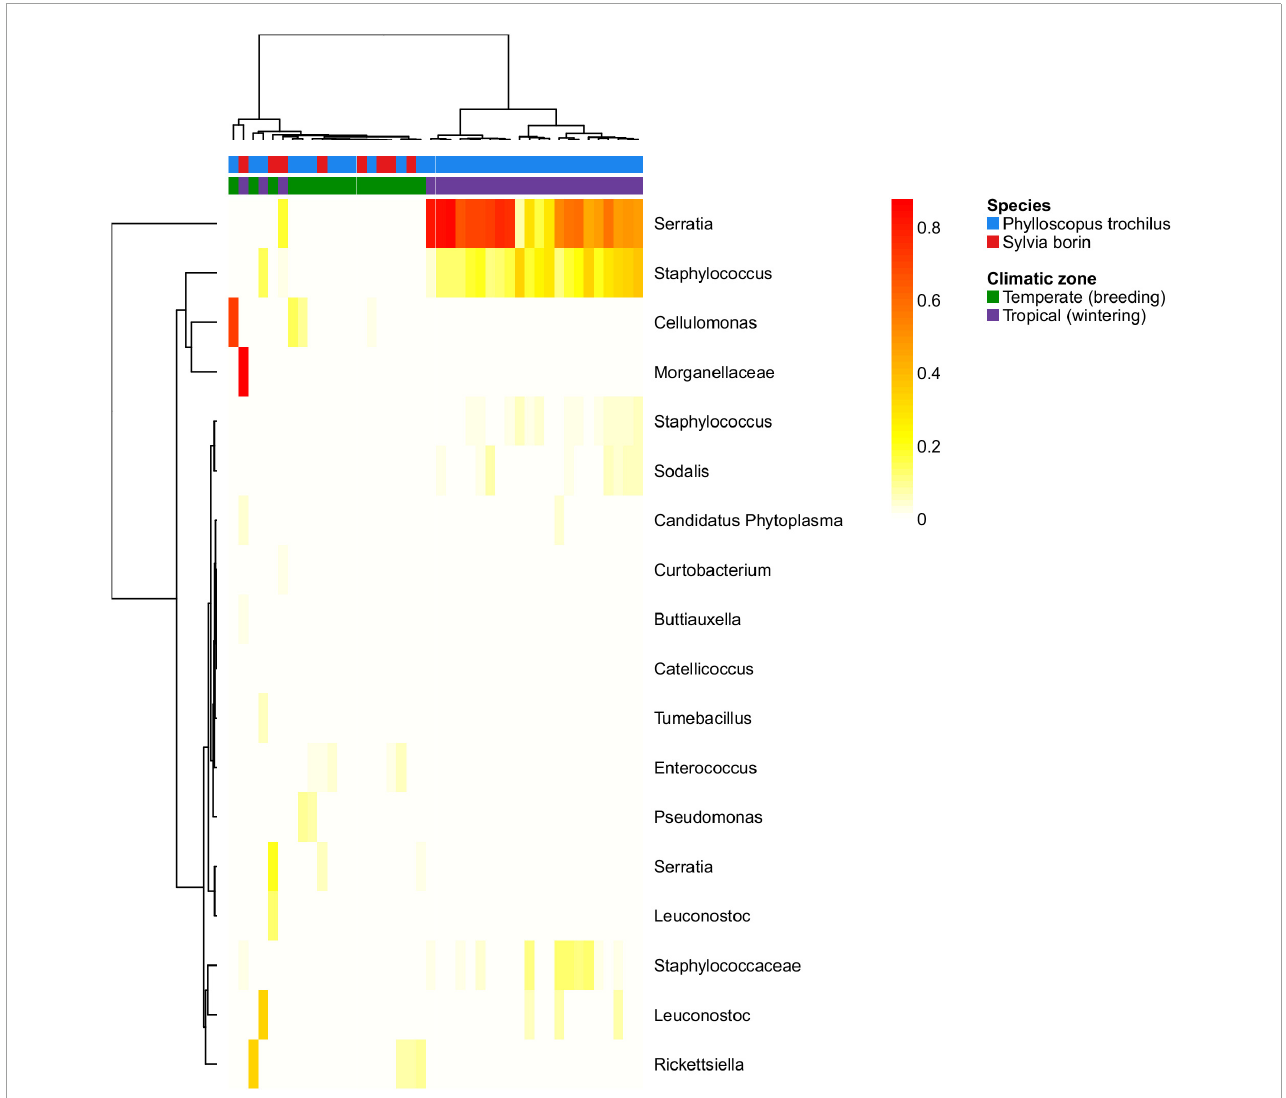
FIGURE5 Heatmap for relative abundances of OTUs that exhibited significant changes between breeding vs. wintering grounds of two temperate trans-Saharan migrants (willow warbler– Phylloscopus trochilus and garden warbler– Sylvia borin ). Matrix was clustered using Ward